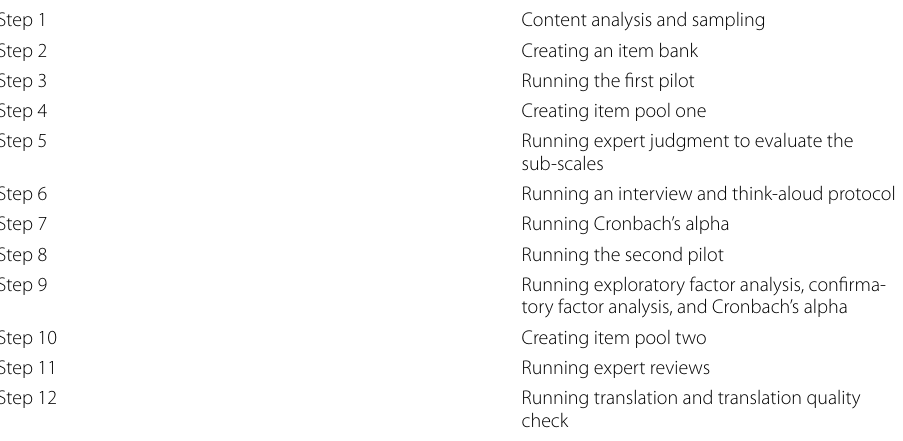
Table 1 Twelve-step questionnaire development and validation